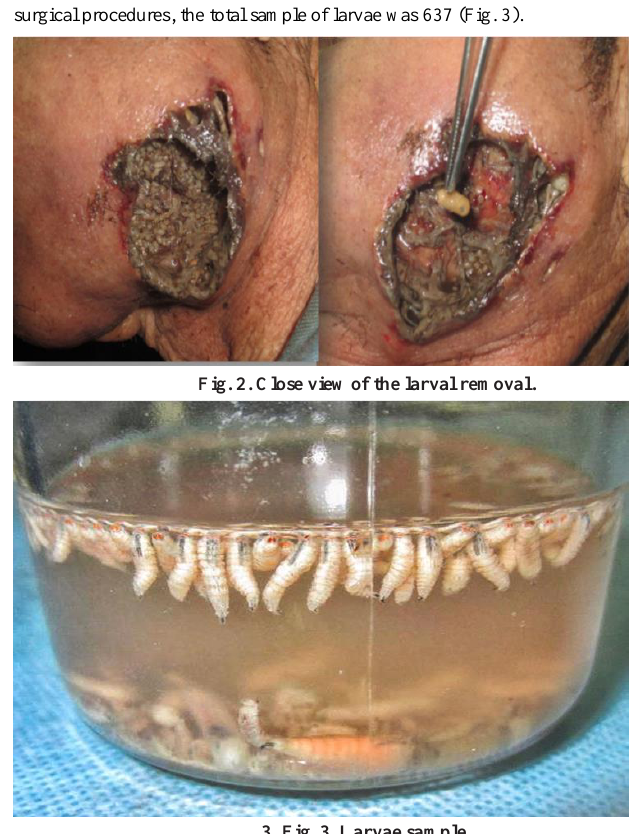
3. Fig. 3. Larvae sample.